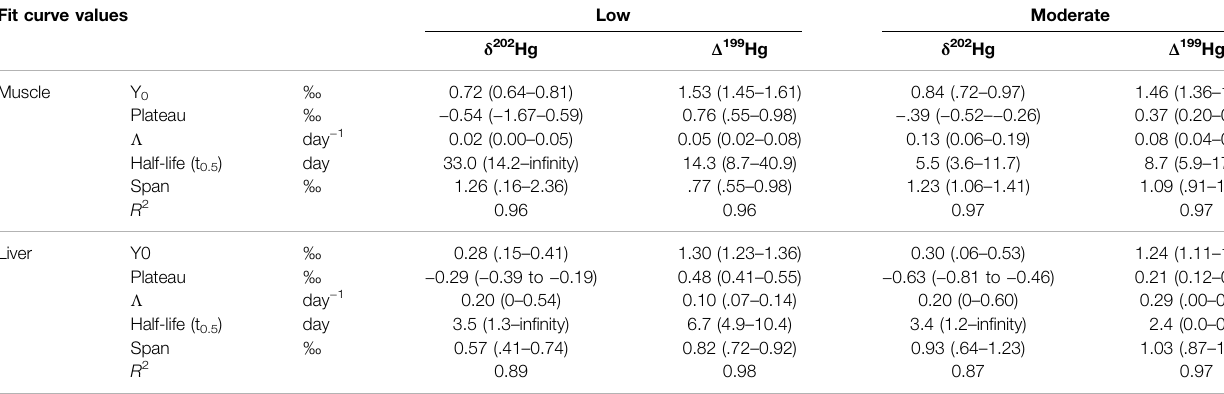
TABLE 2 | Parameters of the fi t curve estimating the Hg isotopic turnover ( δ 202 Hg and Δ 199 Hg) in each tissue and for each treatment. Y 0 is the isotopic value at t 0 . Plateau is the isotopic value reached at the steady state. λ is the rate constant. Half-life is the time required for isotopic values to have shifted to half the span. Span is the interval between the isotopic value at t 0 and at the steady state. Values are means (95% con fi dence interval). Fit curve